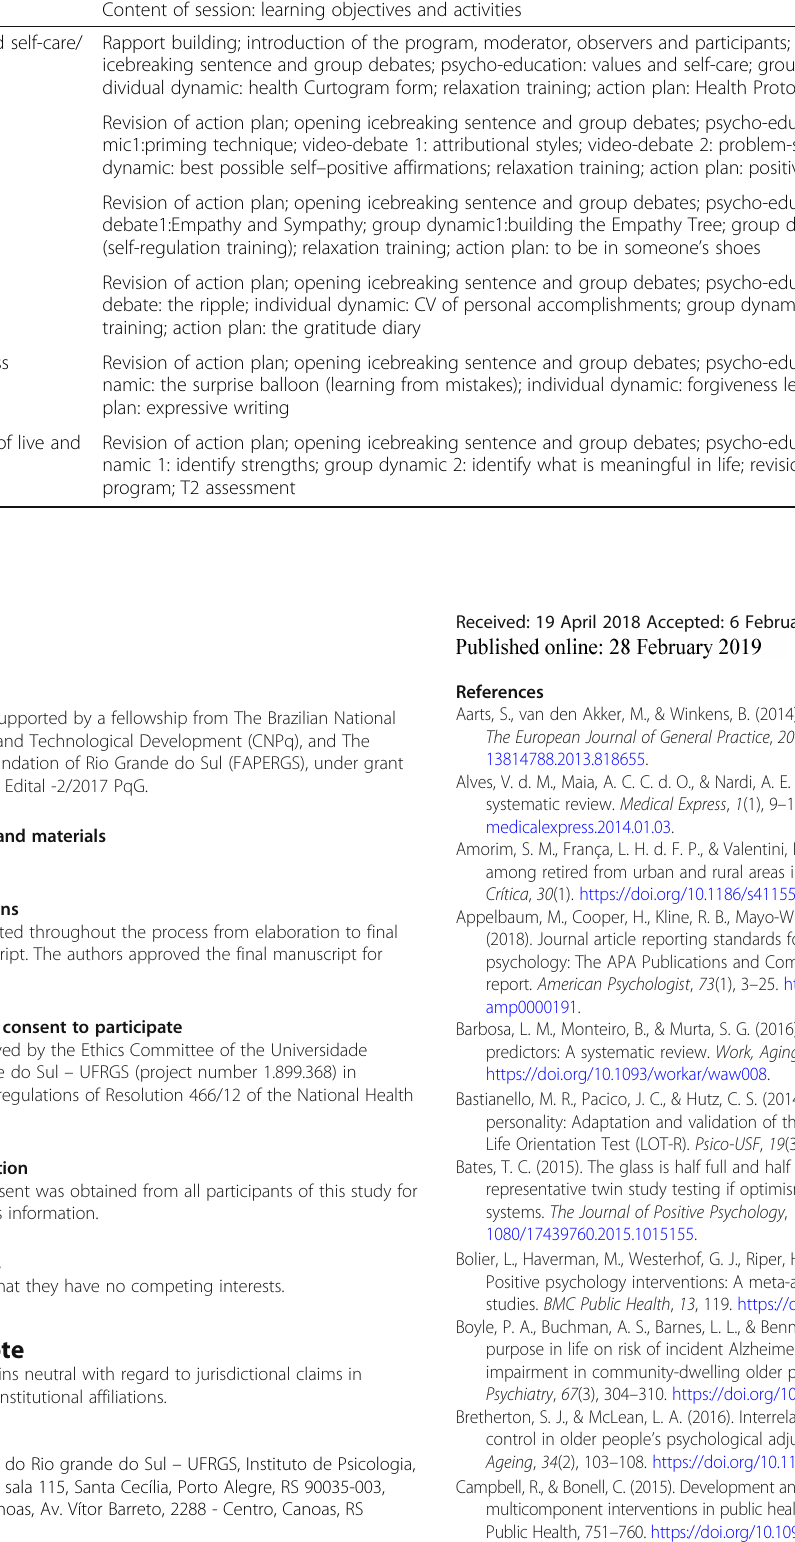
Table 3 Session themes, learning objectives, and activities of Programa Vem Ser Content of session: learning objectives and